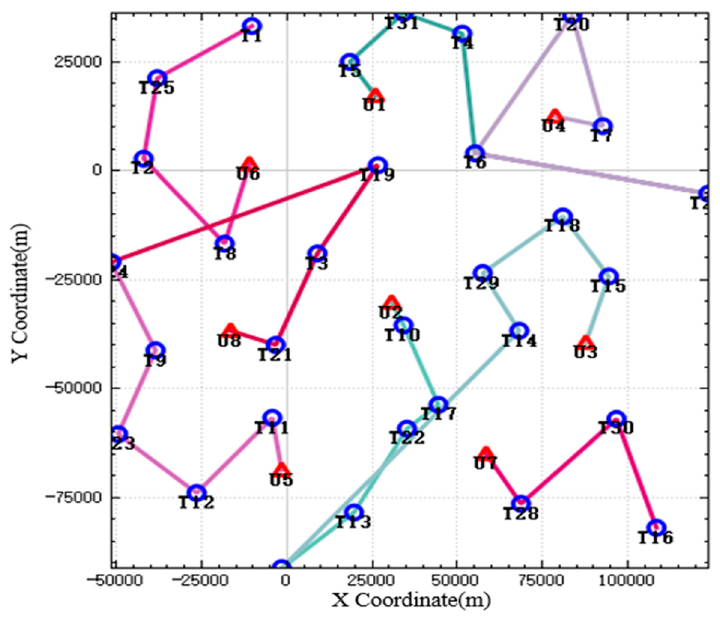
Figure 7. Allocation results before and after the new target appears.